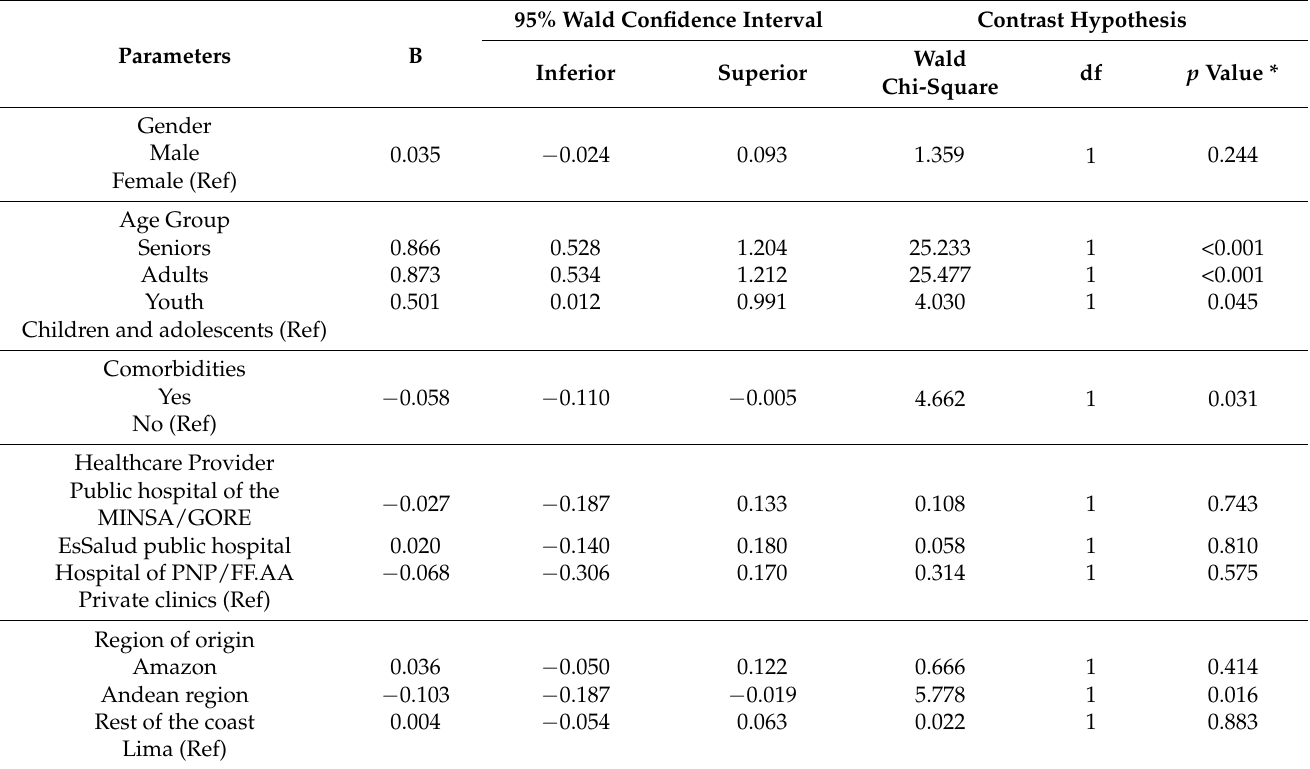
Table 5. Multivariable analysis of pre-hospital time of COVID-19 deaths during the initial pandemic response.